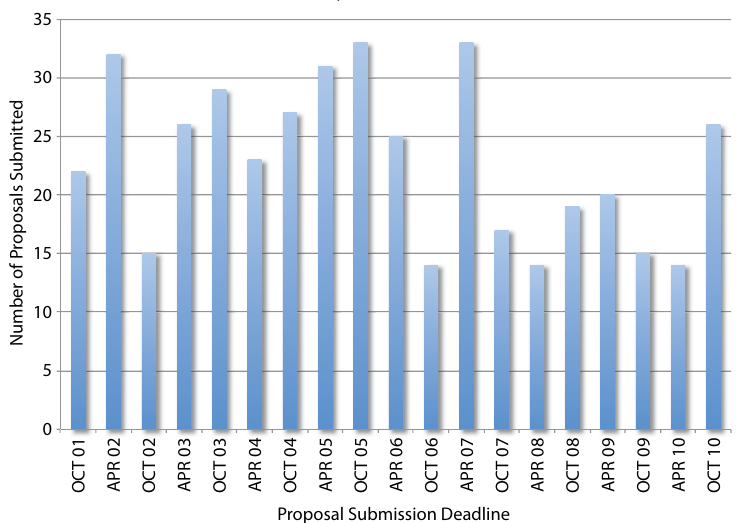
figure 7.3. number of drilling proposals submitted during year 2000–2010. as of early 2011, the number active proponents for these proposals is